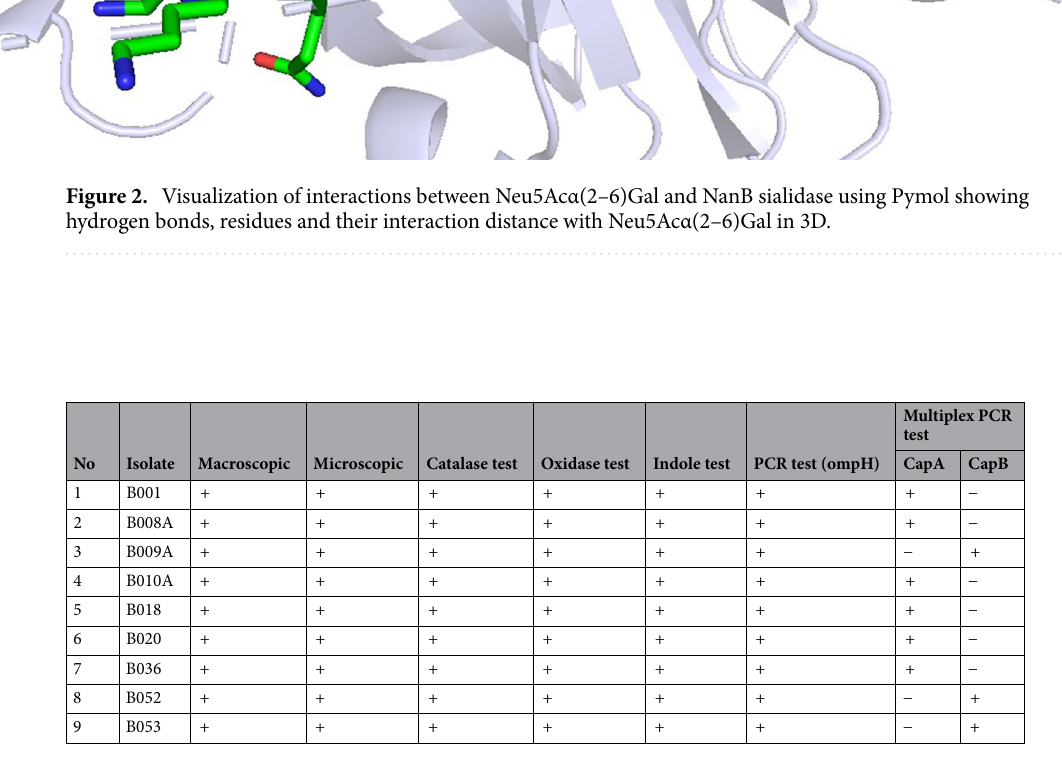
Table 2. Results of culture, identification and confirmation of Pasteurella multocida with various test